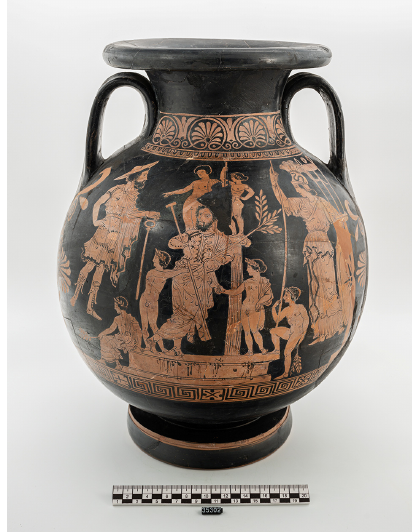
Figure 3. Children of Herakles, and Iolaus. Lucanian red-figure pelike, ca. 400 BCE, from near Heraclea, South Italy. Policoro, Museo Nazionale della Siritide, Italy (inv. N. 35302). (By permission from Ministero della Cultura, Direzione Regionale Musei